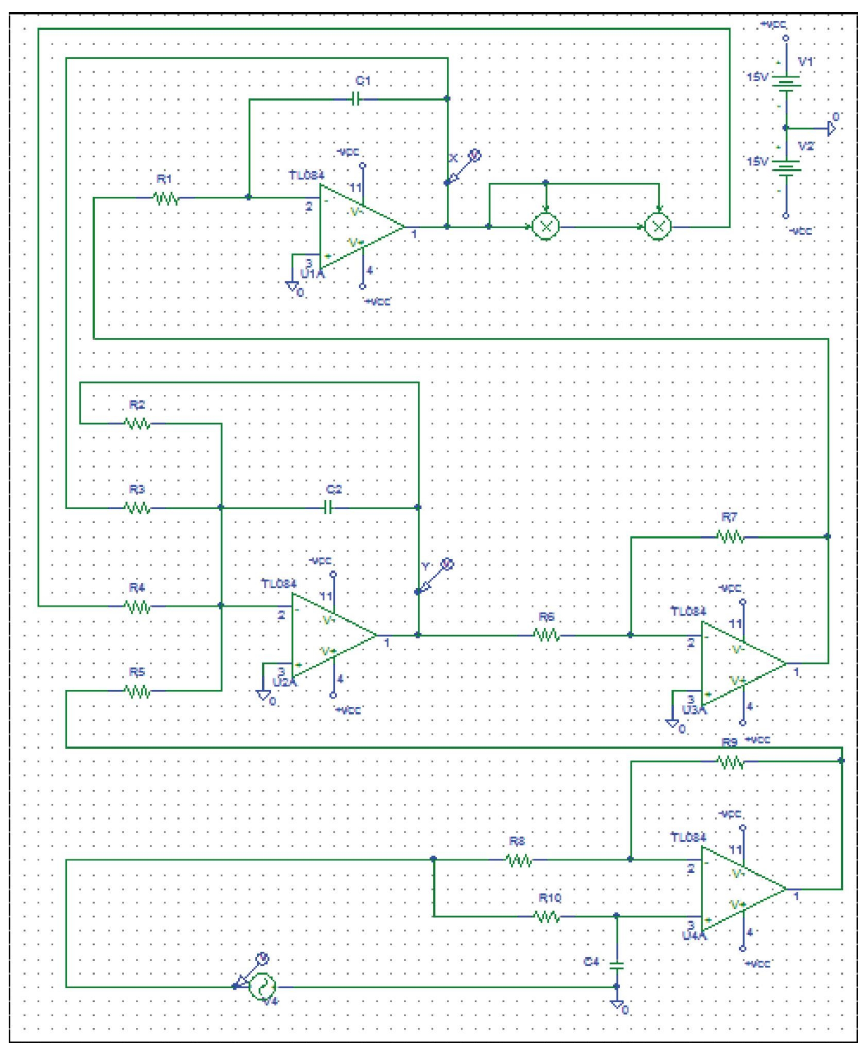
Figure 2: Circuit diagram of system (3) with the values of the components: R � 10 k Ω , R R 10